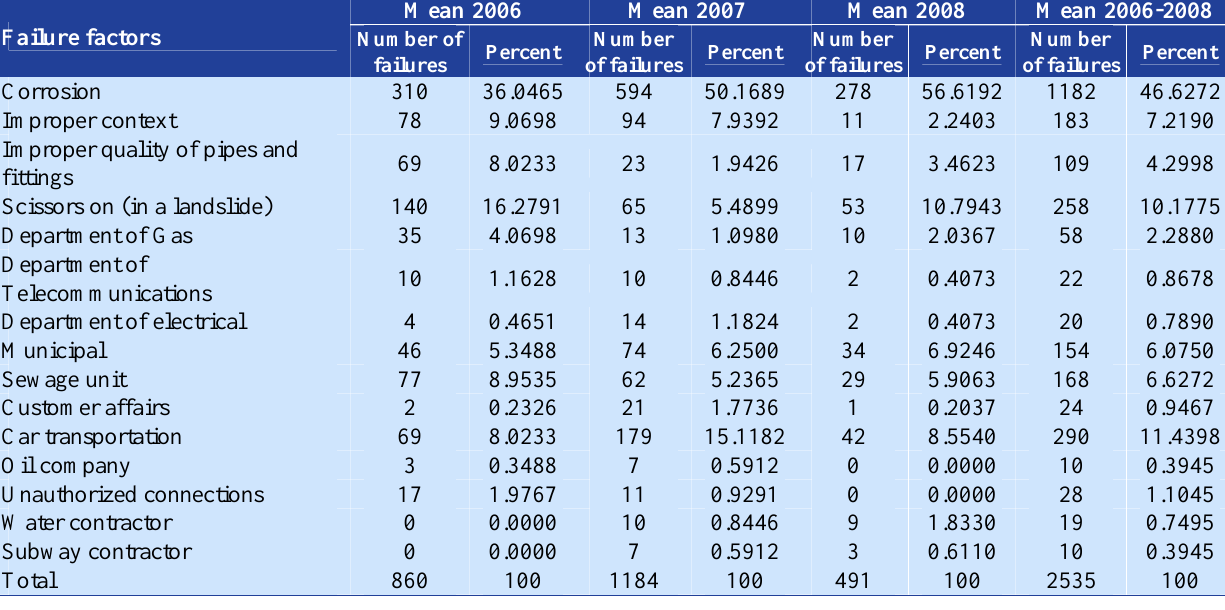
Table 1. Factors and number of failures in Ahvaz, Iran distribution network during 2006-2008 (Ahvaz Water and Wastewater